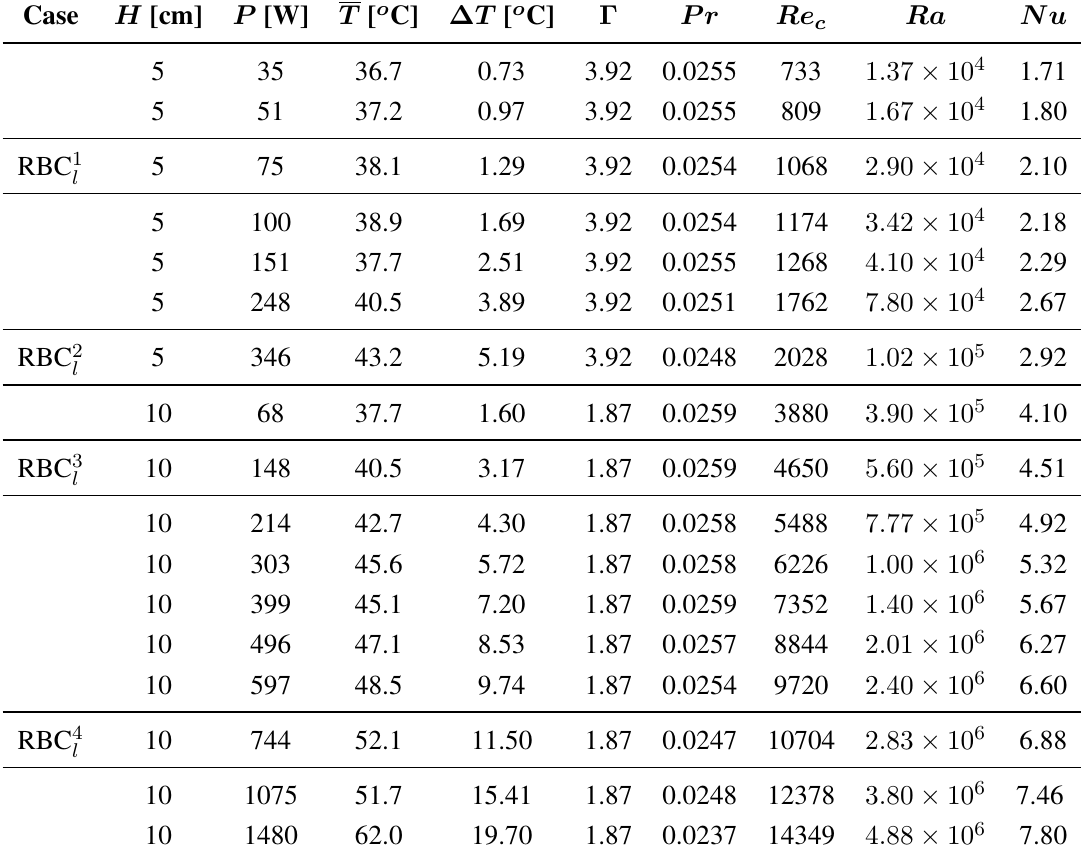
Table 3. Input and output parameters in our suite of laboratory Rayleigh-Bénard convection (RBC) experiments made using liquid gallium. The fluid layer depth is H . The basal heating power is P , which defines the heat flux q = P/A with A = π ( D/ 2) 2 (cid:39) 2 . 8 × 10 − 2 m 2 denoting the fluid layer area. The mean temperature of the fluid is T and the vertical temperature difference is ∆ T . The fluid layer aspect ratio is Γ = D/H . The parameters P r , Ra and Nu are defined in Equations (1), (8) and (24), respectively. The rightmost column show the associated numerical RBC